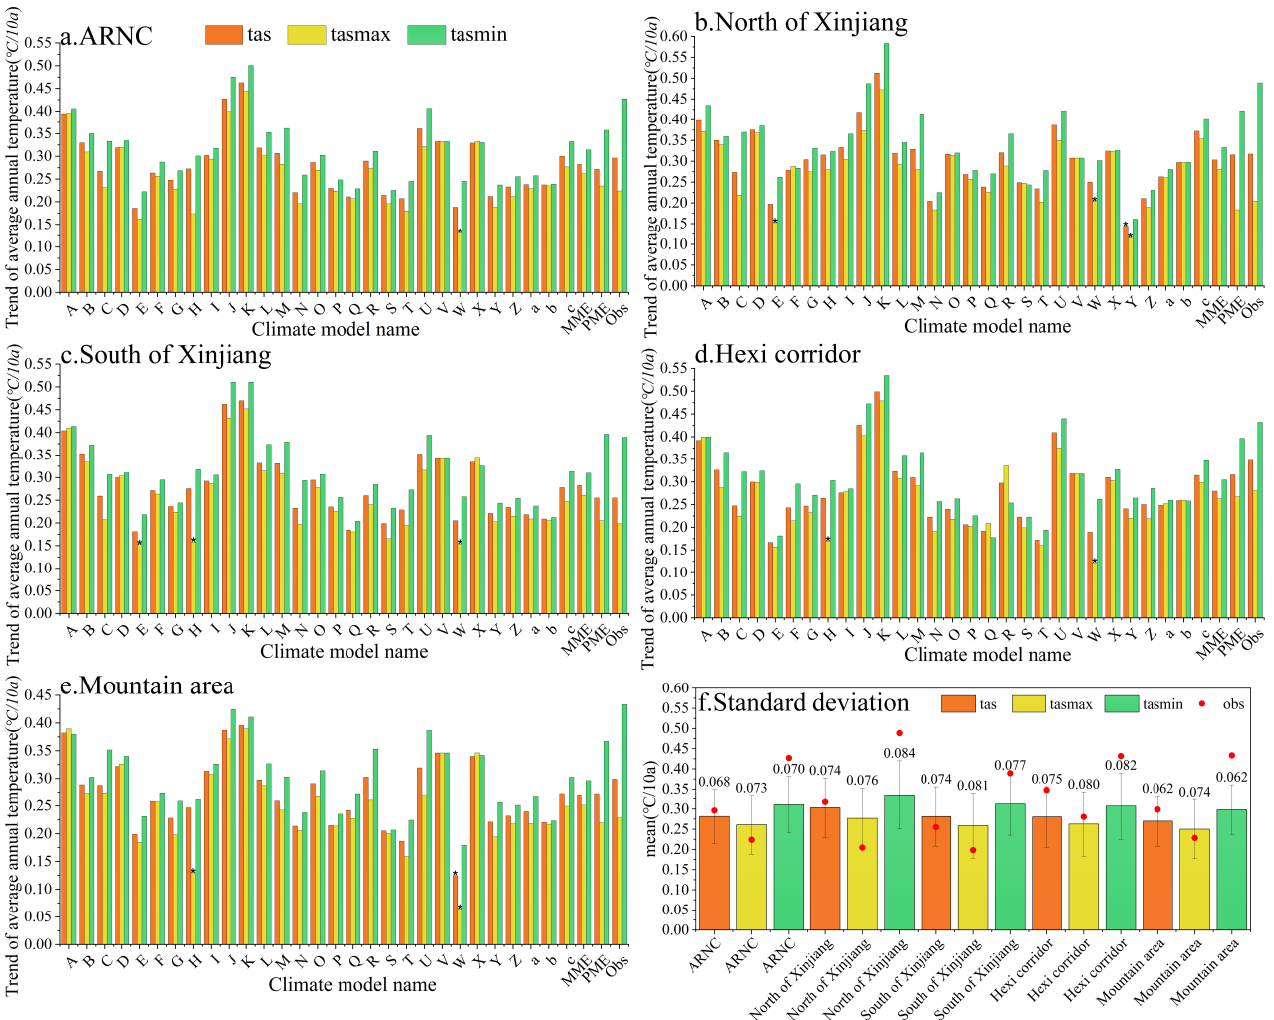
Figure 3. Trend simulation by CMIP6 models for the three temperature elements (tas, tasmax and tasmin) in the ARNC and subregions during 1961–2014 ( a – e ). Letters represent the model ID listed in Table 2. The black star means it does not pass the significance test of 0.01, and the unmarked one means it passes the significance test of 0.01. Standard deviation and mean of the simulated trends for the three temperature elements in the ARNC and subregions during 1961–2014 ( f ). The red dots ( f ) indicate the trends of the observed